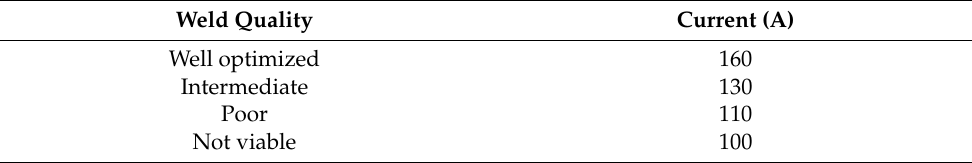
Figure 4. Fixture with coupon in preparation for welding. Table 1. Weld quality of lap-shear coupons by current.